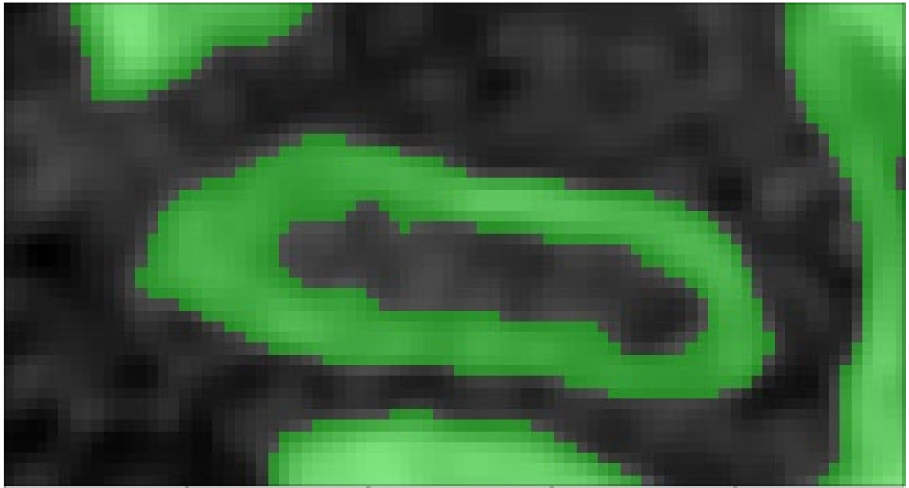
Figure 5. The first stage of segmentation (after